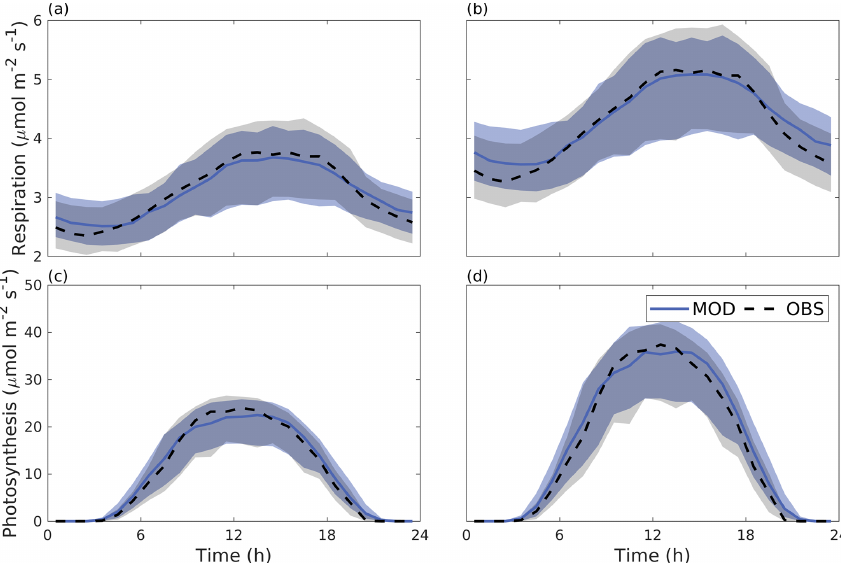
Figure 6. Median diurnal cycle of modelled (blue line) and observed (dashed black line) CO 2 emissions in tree respiration (a–b) and photosynthesis (c–d) from June to August 2016 for the Tilia site (a, c) and the Alnus site (b, d) . The shaded areas show the 25th/75th percentiles.